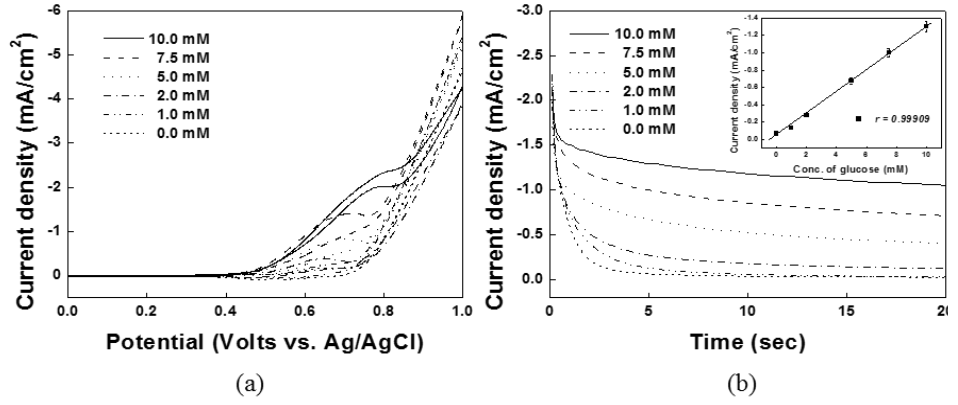
Figure 4. Electrochemical measurements of ( a ) cyclic voltamograms; and ( b ) chronoamperometric response with various glucose concentrations of 0, 1.0, 2.0, 5.0, 7.5 and 10.0 mM. Anodic currents at 0.65 V vs. Ag/AgCl was linearly increased with the concentration of glucose at inset of ( b ).